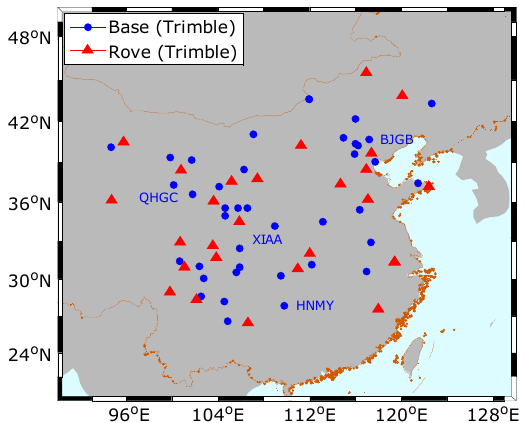
Figure 1. Distribution of homogeneous stations used in China.